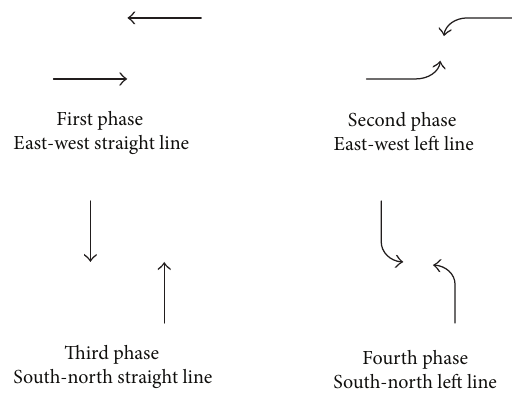
Figure 2: The four-phase order of an